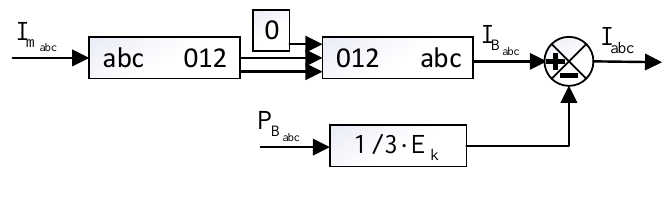
Figure 8. Sequence compensation control block